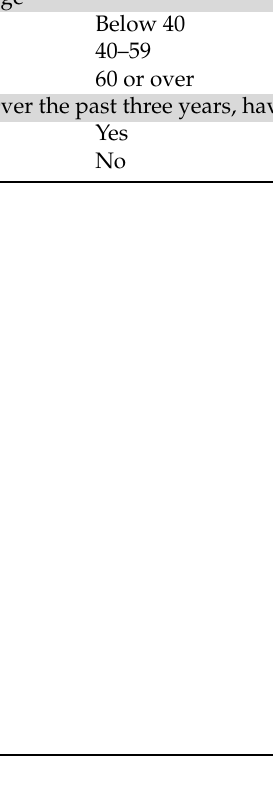
Table 3. Associations between background variables # and the intention to get vaccinated (N = 512). Row % OR U (95%CI) ORm (95%CI)